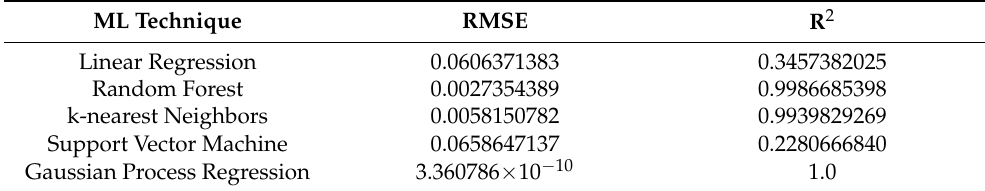
Table 6. CO results.